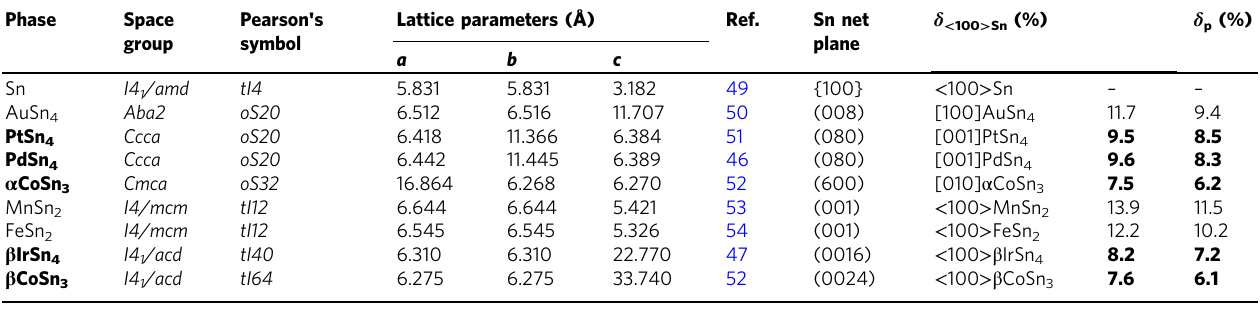
Table 1 Lattice match between Sn net planes of β Sn and selected transition metal stannides Phase Space